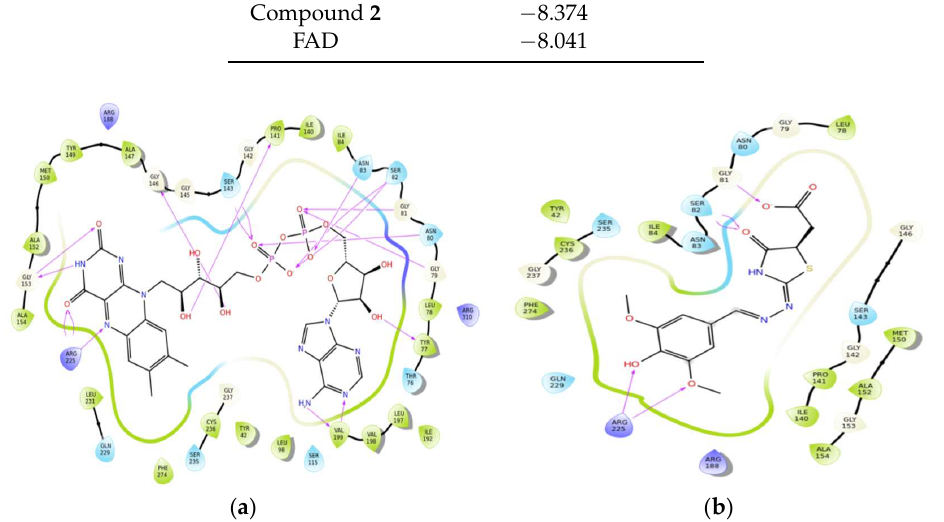
Table 1. Docking score of the compound 2 and the bound ligand FAD.